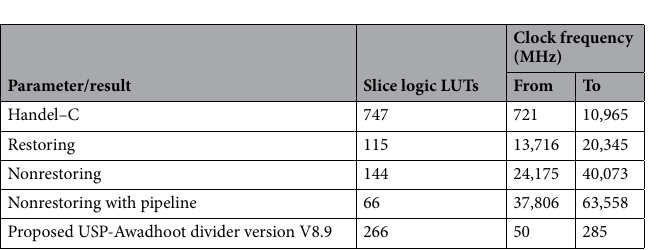
Table 1. Summary of a comparative study on different division algorithm-based dividers.